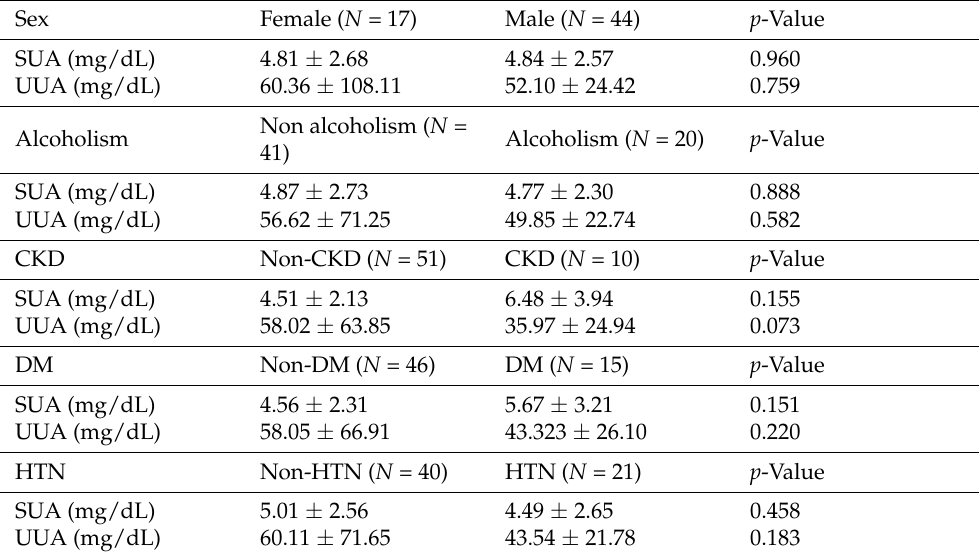
Table 3. SUA levels in different patient